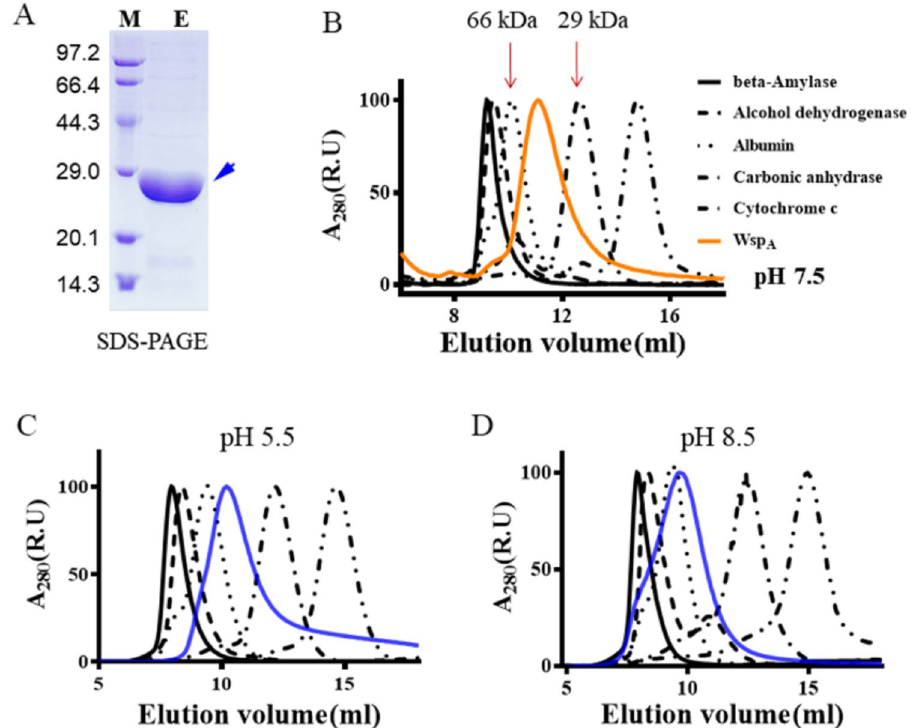
Figure 3. In vitro expression of Wsp A and analysis of the protein polymerization state. ( A ) In vitro expression of Wsp A by the E. coli BL21/pET28a protein expression system. M marker protein, E eluted fraction. Blue arrow points to the target protein. ( B ) The protein polymerization state of native Wsp A analyzed by FPLC at pH 7.5. ( C ) The effect of unfavorable acidic condition (pH 5.5) on the dimer of Wsp A . ( D ) The effect of unfavorable alkaline condition (pH 8.5) on the dimer of Wsp A